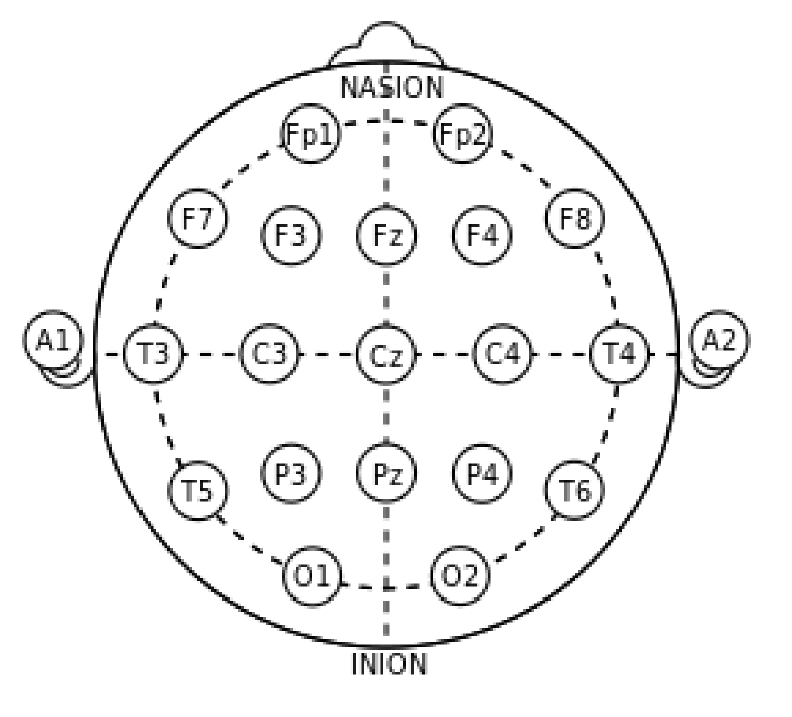
Figure 4. The typical sensor layout for detecting Electroencephalography (EEG)